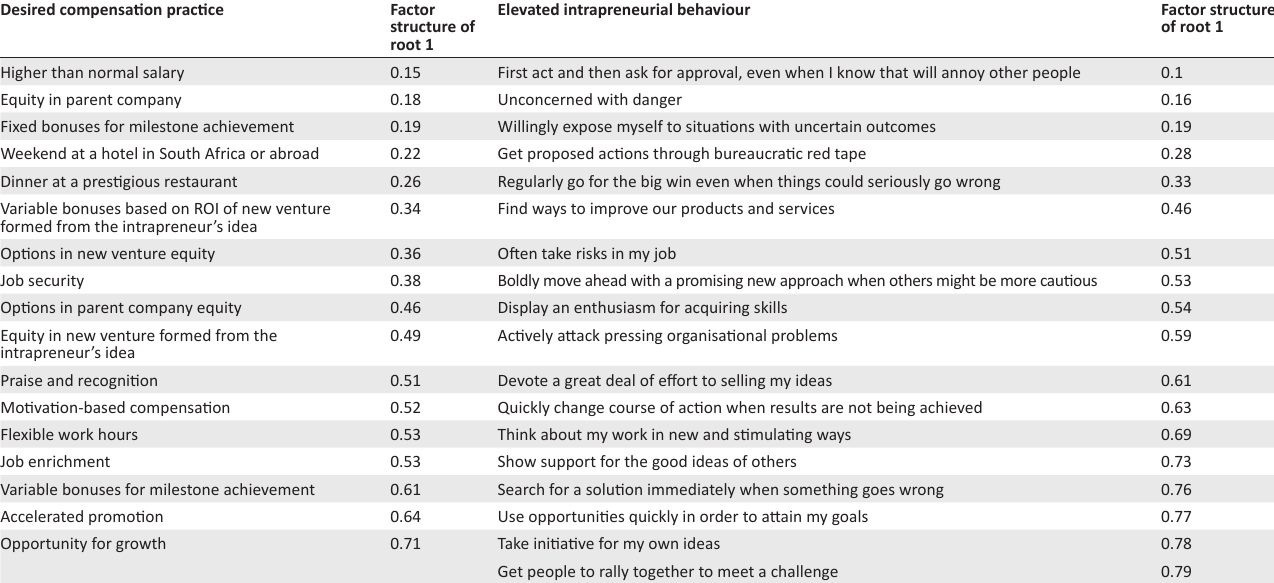
TABLE 3: Hypothesis 2: Desired compensation practices and elevated intrapreneurial